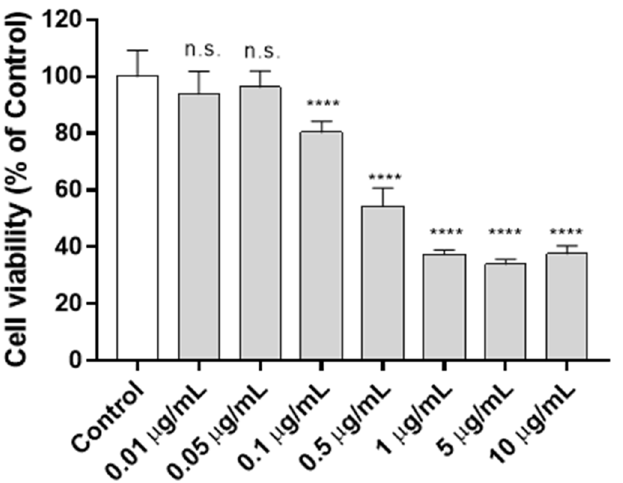
Figure 4. Human keratinocyte HaCaT cell viability after 24 h exposure to GNPs at different concentrations (from 0 µ g/mL (control sample) to 10 µ g/mL) measured by the (3-(4, 5-dimethylthiazol-2-yl)-2, 5-diphenyl tetrazolium) (MTT) assay. Results are expressed as % of the control sample and as the mean ± standard deviation of six replicates. The results of the statistical analysis with respect to control are indicated in the graph: **** p < 0.0001; n.s: not significant. The limit is 70% of cell viability for the materials to be considered non-cytotoxic according to the ISO-10993 standard.